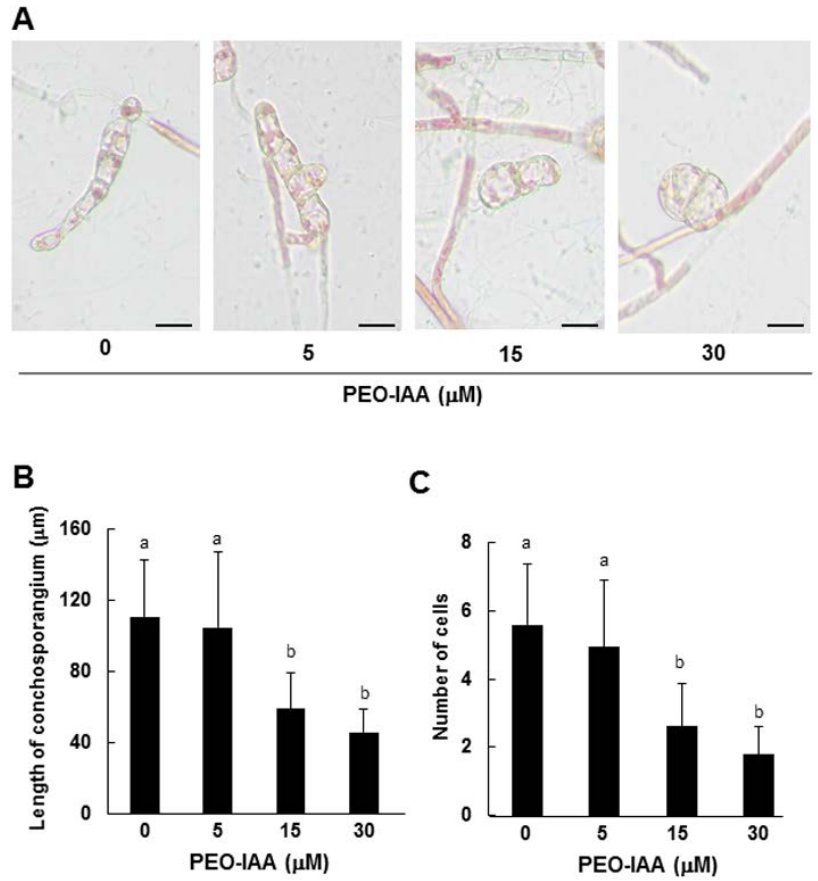
Figure 6. Effects of PEO-IAA on the tip growth of conchosporangia produced on conchocelis filaments. ( A ) Photographs of typical conchosporangia treated with 0, 5, 15, or 30 μM PEO-IAA for 7 days. Scale bars: 25 μm. ( B , C ) Effects of exogenously supplied IAA on the growth of side branches from single-celled conchosporangia, including the total length ( B ) and cell number ( C ) after 7 days of culture. Error bars indicate the standard deviation of triplicate independent experiments ( n = 3), and different lowercase letters denote significant differences, as determined by Tukey’s test ( p < 0.05).